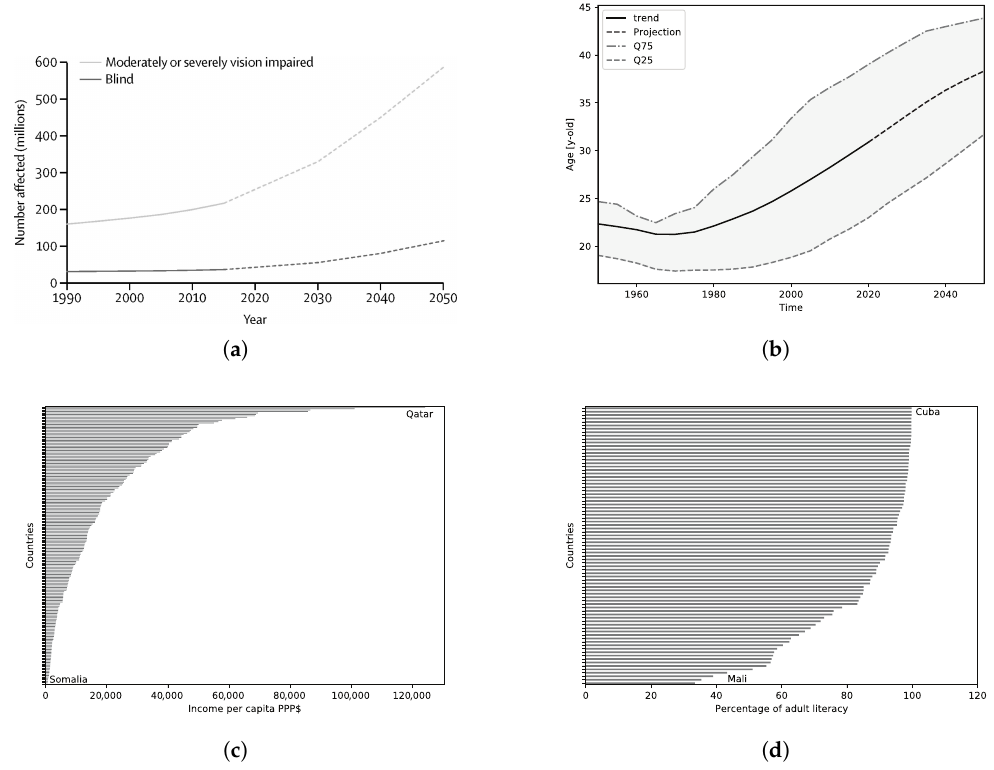
Figure 2. World’s population differences probably affecting indoor comfort perception. In particular, that could skew the results obtained through qualitative questionnaires. ( a ) Eye-sight affections (extracted from [53]). ( b ) Population average world’s age trend; ( c ) Projected 2020’s per capita Purchasing Power Parity (PPP) differences; and, ( d ) 2011’s Percentage of adult literacy breach based on free material from GAPMINDER.ORG (accessed on 23 December 2019) , CC-BY